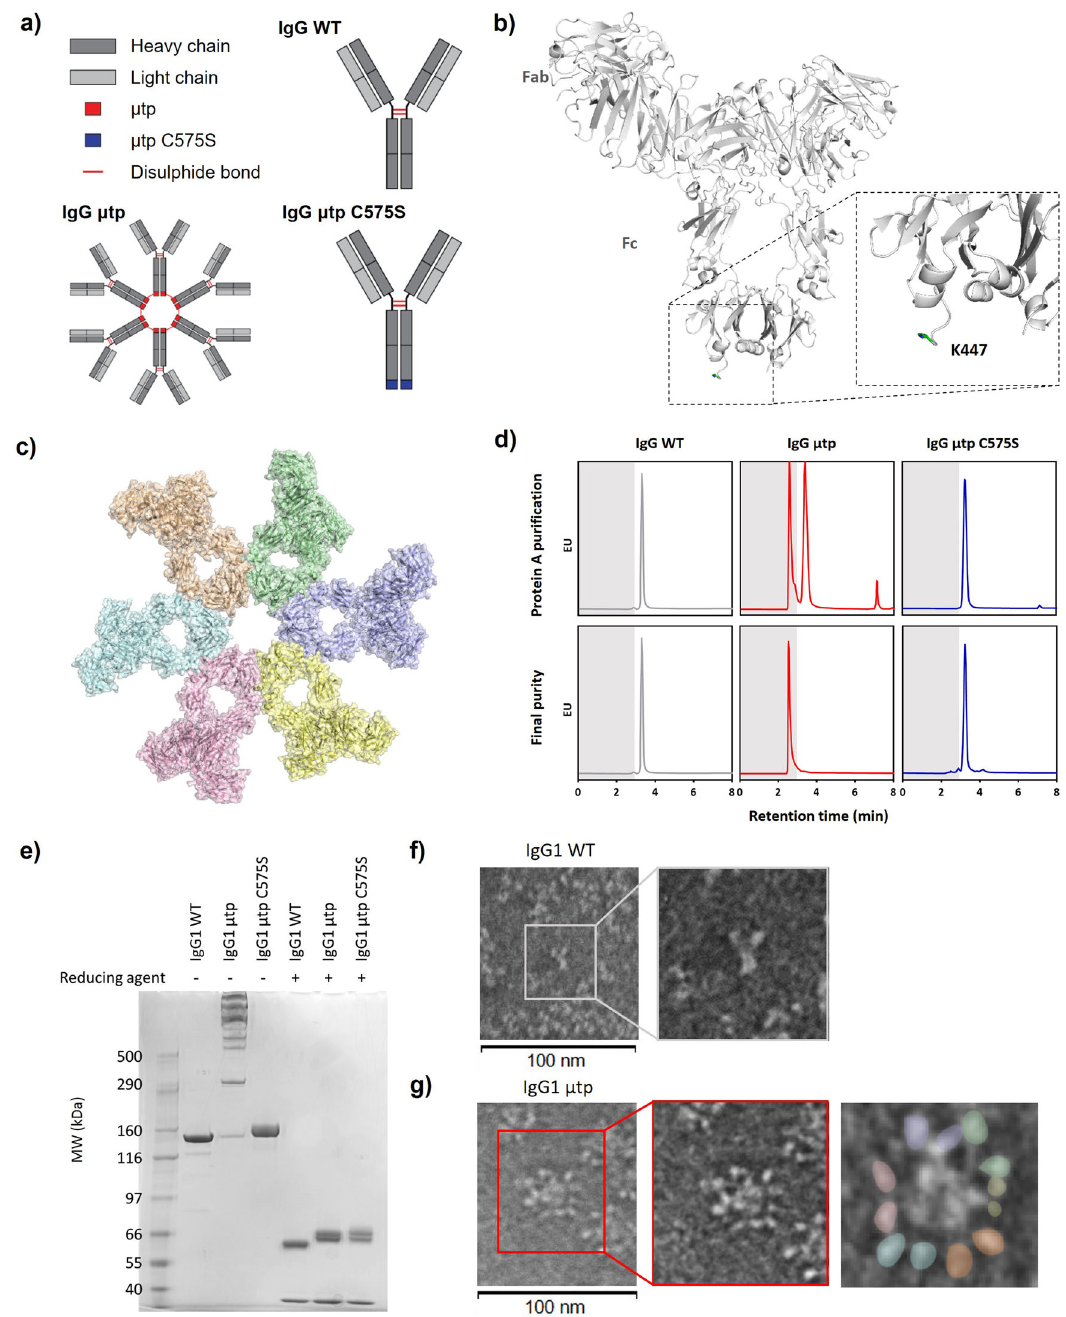
Fig. 1 Generation and characterisation of hIgG1 μ tp fusion mAb. a Schematic of the hIgG μ tp hexamer and hIgG1 μ tp C575S monomer mAb. b Structure of IgG-b12 hexamer (PDB: 1HZH). The C-terminal lysine (K447) is highlighted in the insert and coloured green. c Hexameric IgG structure observed in the crystal packing arrangement of IgG-b12 (PDB: 1HZH). d CHO produced hIgG1 μ tp fusion mAb were puri fi ed using protein A chromatography followed by size- exclusion chromatography, representative SE-UPLC chromatograms shown for rituximab hIgG1 wild-type (grey), rituximab hIgG1 µ tp pre-formed hexamer (red), and rituximab hIgG1 µ tp C575S on-target hexamer (blue). e 3 – 8% Tris-acetate SDS-PAGE analysis to assess the size of the puri fi ed hIgG1 μ tp fusion mAb in non-reduced and reduced forms. f , g For negative stain electron microscopy, mAb were applied to glow discharged electron microscopy grids stained with 2% uranyl acetate solution. Images were collected using a Hitachi HT7700 Transmission Electron microscope at ×80,000 magni fi cation, single images were processed using Adobe Photoshop. Images shown depict f rituximab hIgG1 wild-type and g rituximab hIgG1 µ tp pre-formed hexamer. Rituximab hIgG1 µ tp pre-formed hexamer with Fab pairs highlighted as separate colours shown separately. Scale bar 100